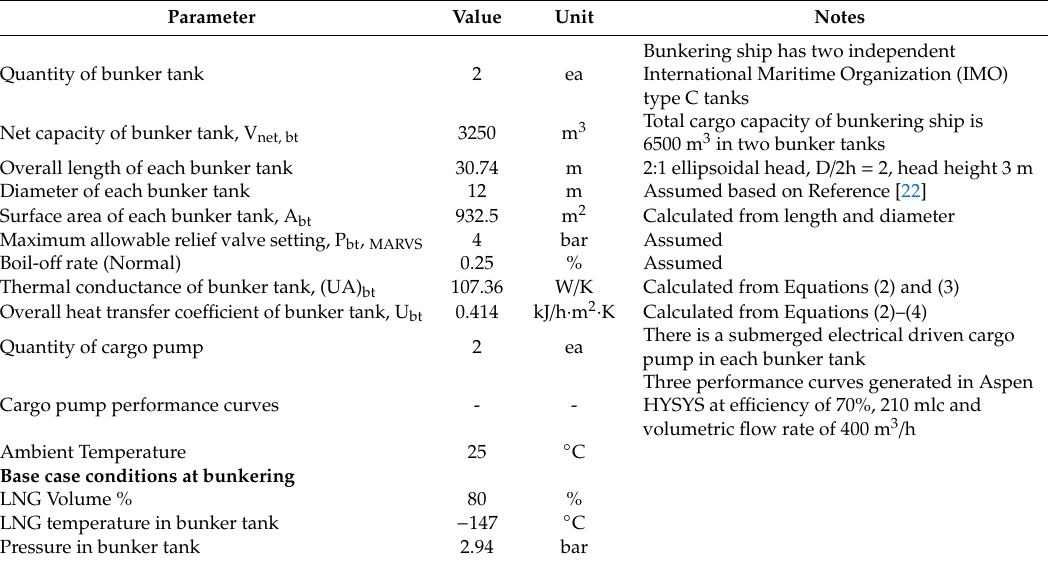
Table 2. Specification and initial condition of LNG bunker tank in bunkering ship.